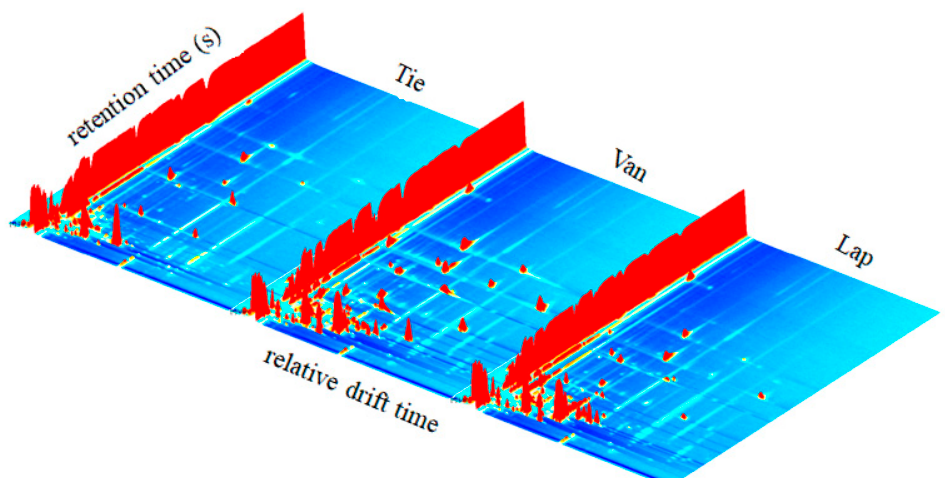
Figure 1. Differences in the three-dimensional (3D)-topographic of volatile compounds in cherry fruits from three cultivars (Tie: cherry cultivar Tieton; Van: cherry cultivar Van; Lap: cherry cultivar Lapins). GC-IMS detection results were shown in a pseudo-color map (Figure 2) to differenti- ate the topographic plot of cherry fruits from three cultivars intuitively. In the two-dimen- sional (2D) topographic map of different cultivars, X and Y axis meant the drift time and retention time, respectively. Each point represented one type of volatile compound or a dimer in the spectrum. The grayscale image represented the normalized difference. The red or blue point indicated that the signal was strong or weak, which meant that the rela- tive content was higher or lower. The integration parameters of volatile compounds were detected in Table 2. Moreover, it could be observed that some flavor compounds appeared as proton-bound monomers and dimers. Table 2. GC-IMS integration parameters of volatile compounds detected in cherry fruits and their wines.